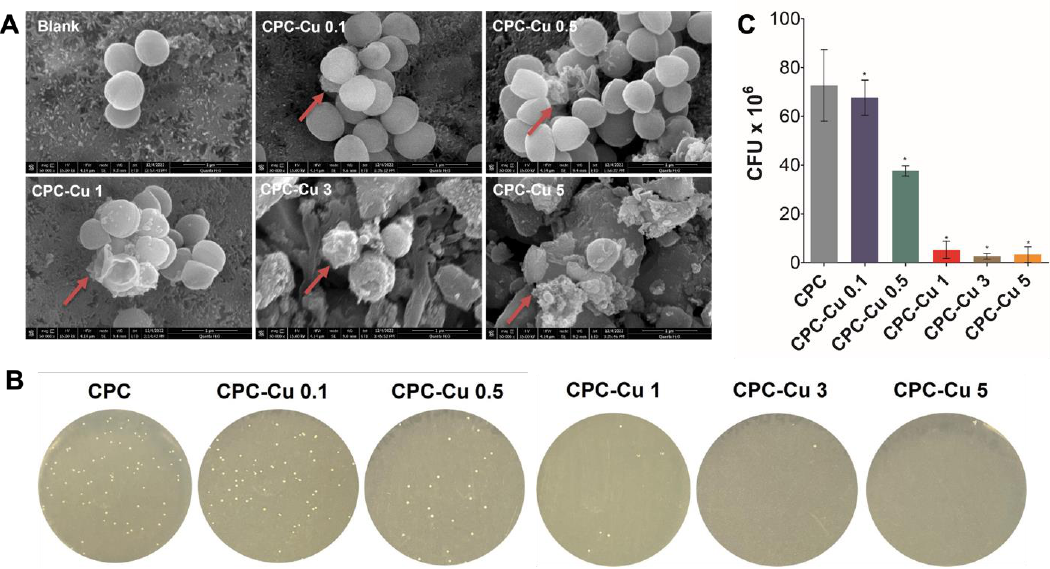
Figure 6. The antimicrobial activity of CPC and Cu loaded CPC scaffolds; ( A ) scanning electron microscopy images showing the deformed S. aureus morphology; ( B ) quantified S. aureus bacteria; and ( C ) colony forming units (CFU) of S. aureus cultured on Luria agar plates after treatment for 24 h. The data are represented as mean ± standard deviation ( n = 3). The significance of difference * p < 0.05 for various groups compared to CPC.